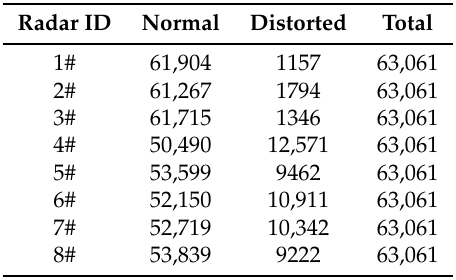
Table 1. The number of normal signals and distorted